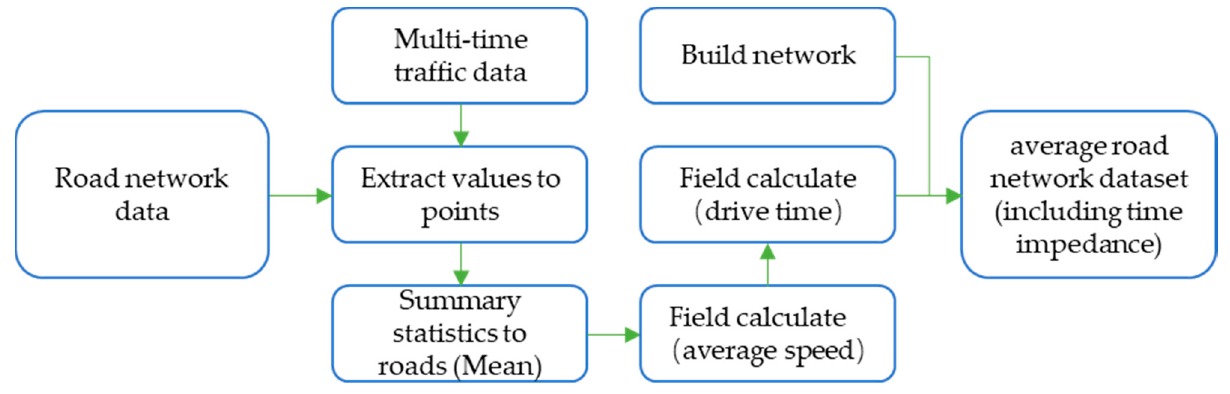
Figure 4. Flowchart for generating the average-speed road